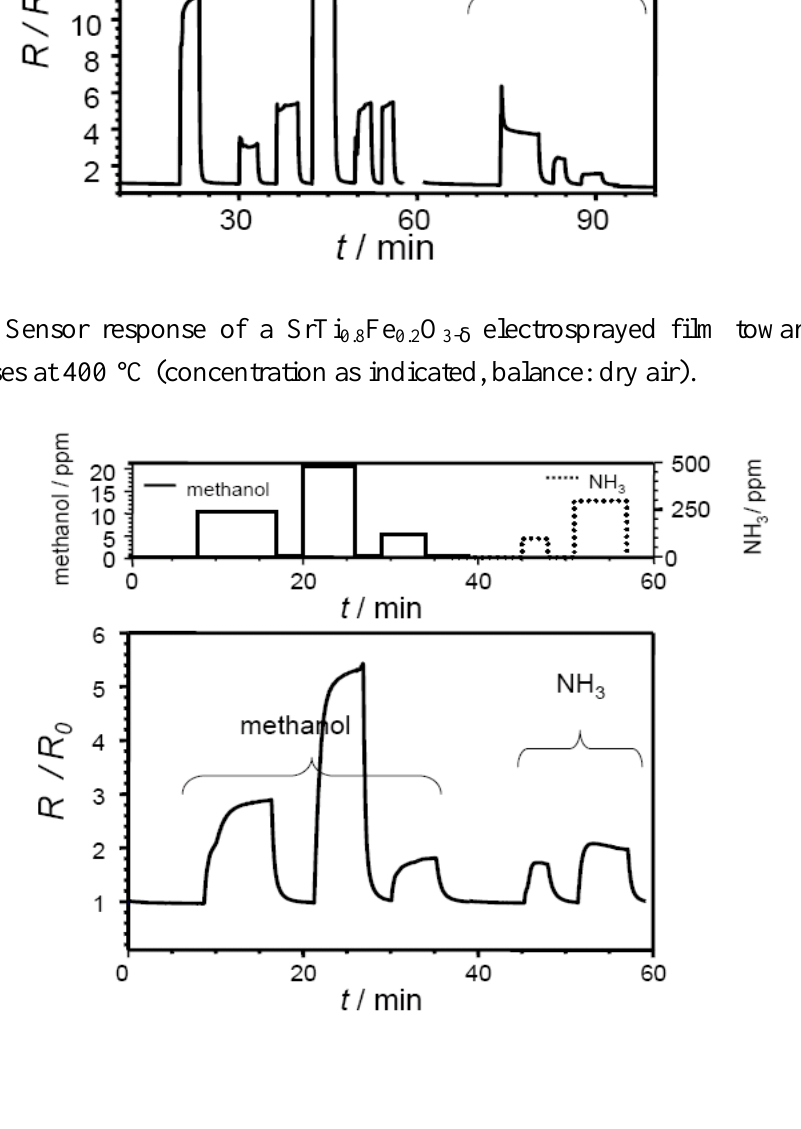
Fe O electrosprayed film towards different 0.8 0.2 3- d